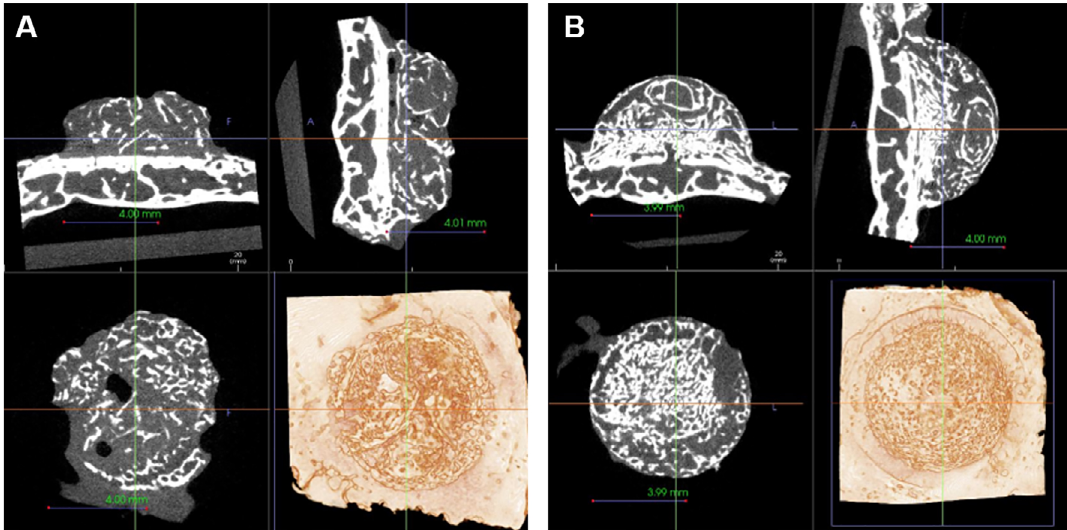
New bone formation is observed more evenly distributed at experimental group I (B) than group II (A). Figure 5- Cross-sectional and 3D rendering of micro-CT images of a specimen at week